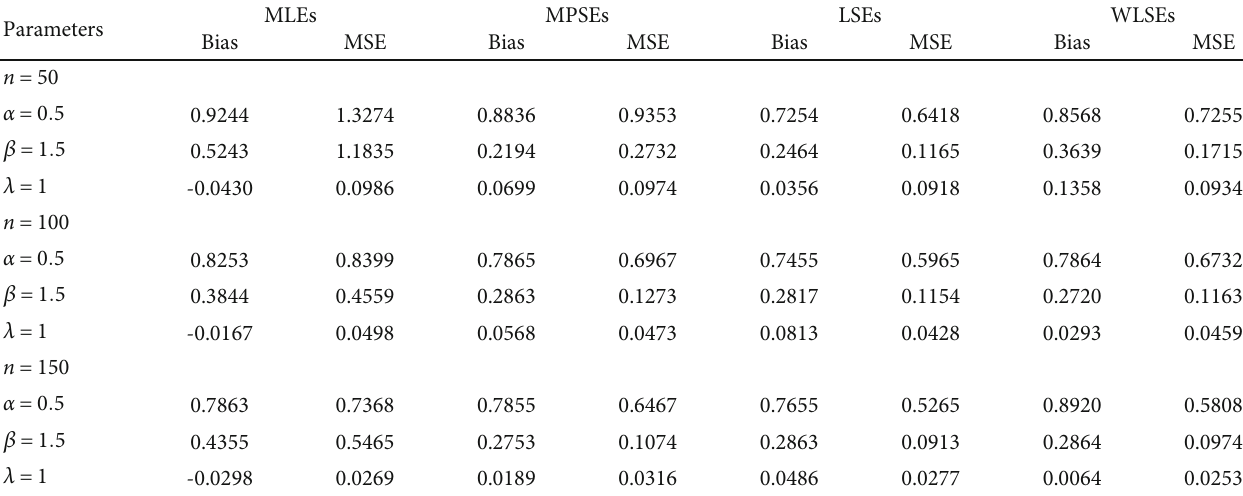
Table 2: Bias and MSE values for α , β , and λ of the XGAIW